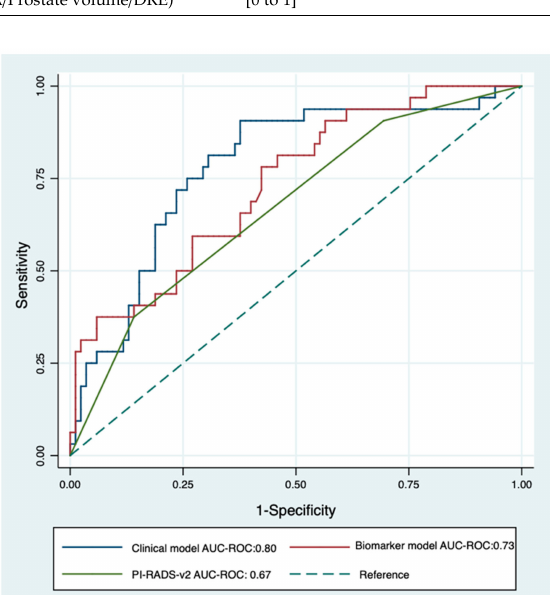
Figure 4. Receiver operating characteristics curve for PI-RADS-v2 score (green) and multivariable logistic regression of clinical model (PI-RADS-v2 score + PSA density + Age + DRE; blue) and biomarker model (PI-RADS-v2 score + SelectMDx-v2; red) for the detection of high-grade cancer on image-guided biopsy. The dotted diagonal line is the reference line (AUC =